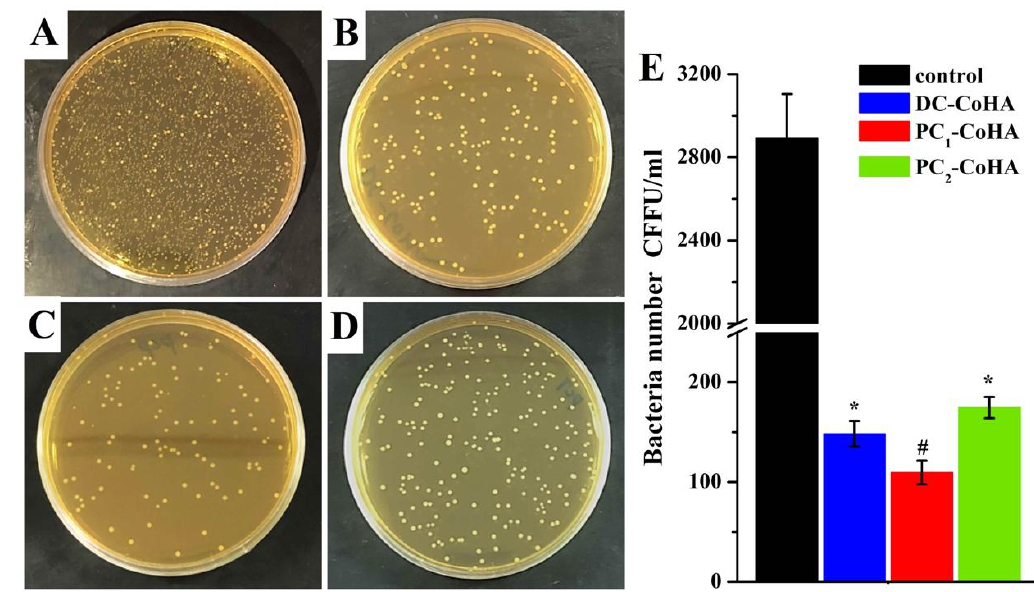
Figure 11. Images of the antibacterial results for relatively bacterial colonies on agar plates: ( A ) control (BHI), ( B ) DC-CoHA, ( C ) PC 1 -CoHA and ( D ) PC 2 -CoHA sample. ( E ) Antibacterial activity of the analyzed sample on E. coli . (*: significantly smaller than control group. #: significantly smaller than all the other samples, p < 0.05, mean ± standard deviation (SD), n = 4).